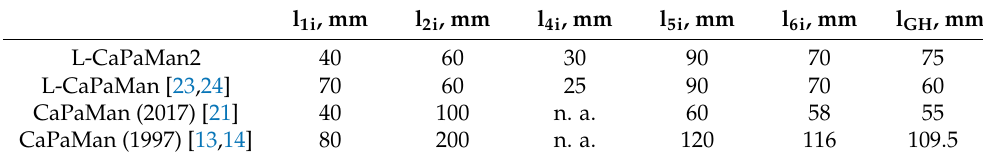
Table 1. Design parameters for L-CaPaMan2 as compared with previous designs, Figure 1.